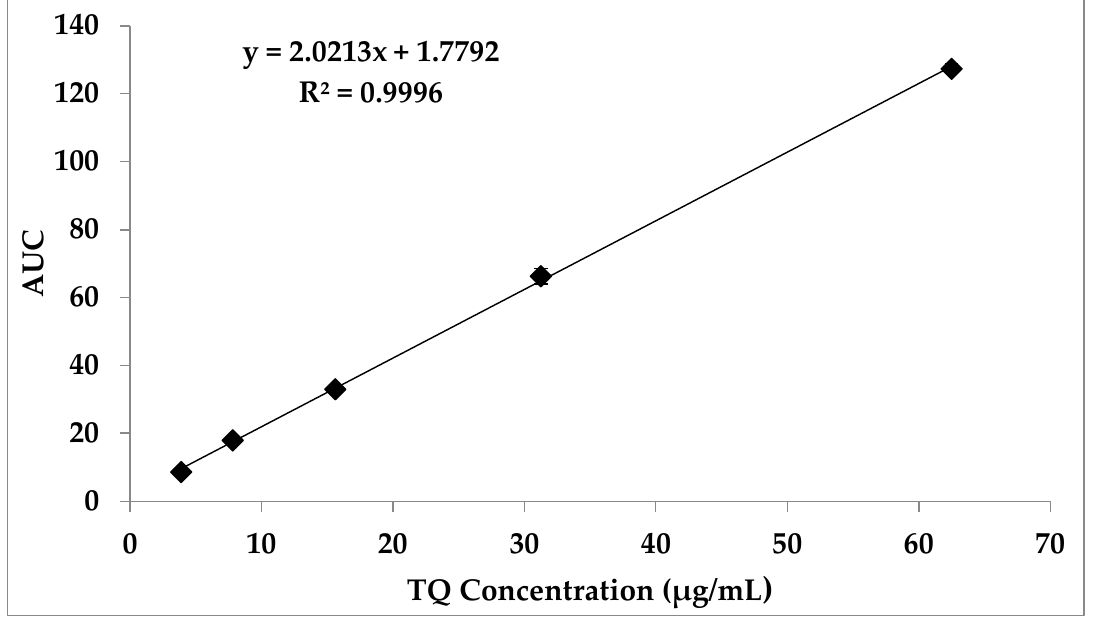
Figure 9. Calibration curve of TQ over a concentration range of 3.9 to 62.5 µg/mL.